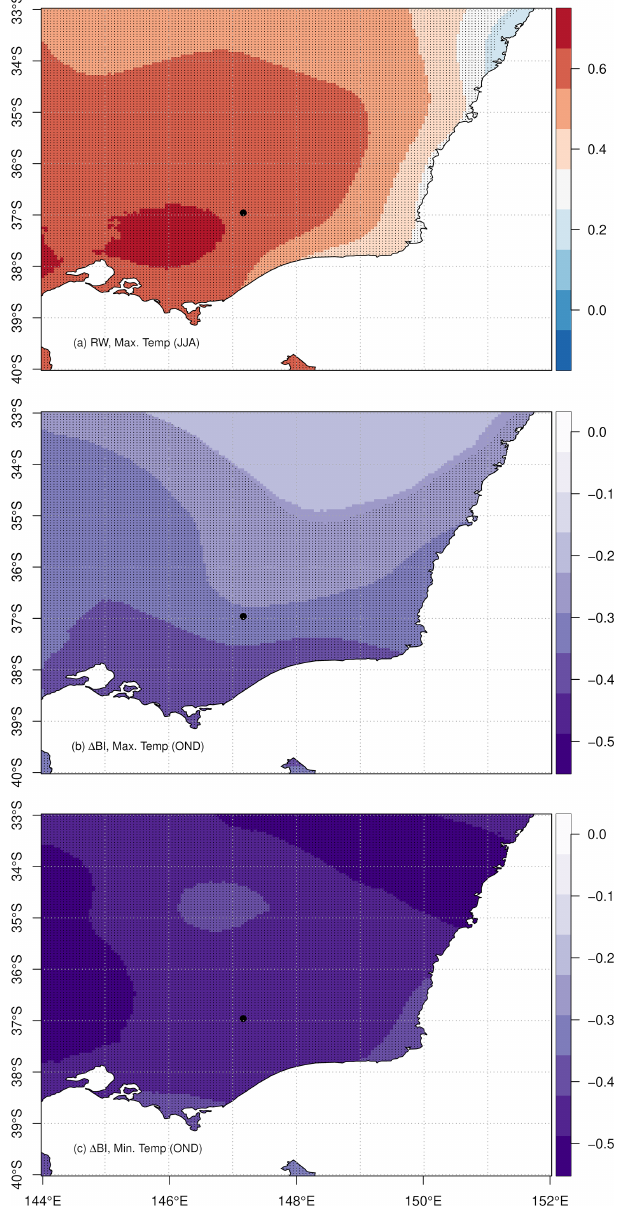
Figure 7. RW and (cid:49) BI chronology correlations with AGCD mean monthly temperature for the 1929–1998 period. (a) RW correla- tion with mean June, July and August (winter) maximum tempera- tures, (b) (cid:49) BI correlation with mean October, November and De- cember maximum temperatures, and (c) (cid:49) BI correlation with mean December minimum temperature. Shaded areas represent statisti- cally significant correlations ( p < 0 . 05), and the study site location is marked by the black dot.